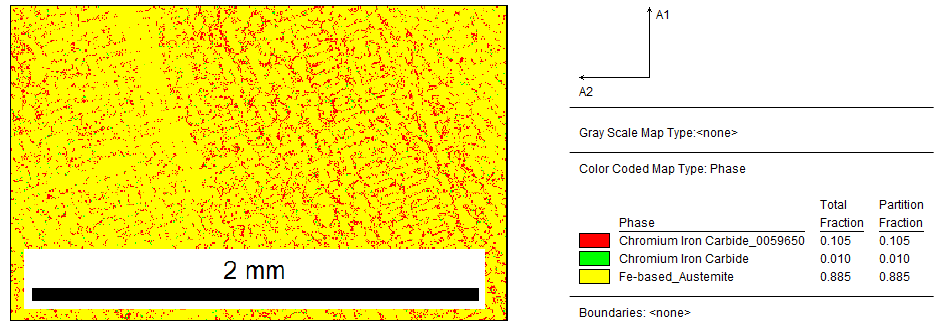
Figure 4. Reference sample: distribution map of occurring phases, red area — M 7 C 3 , green area — M 3 C.